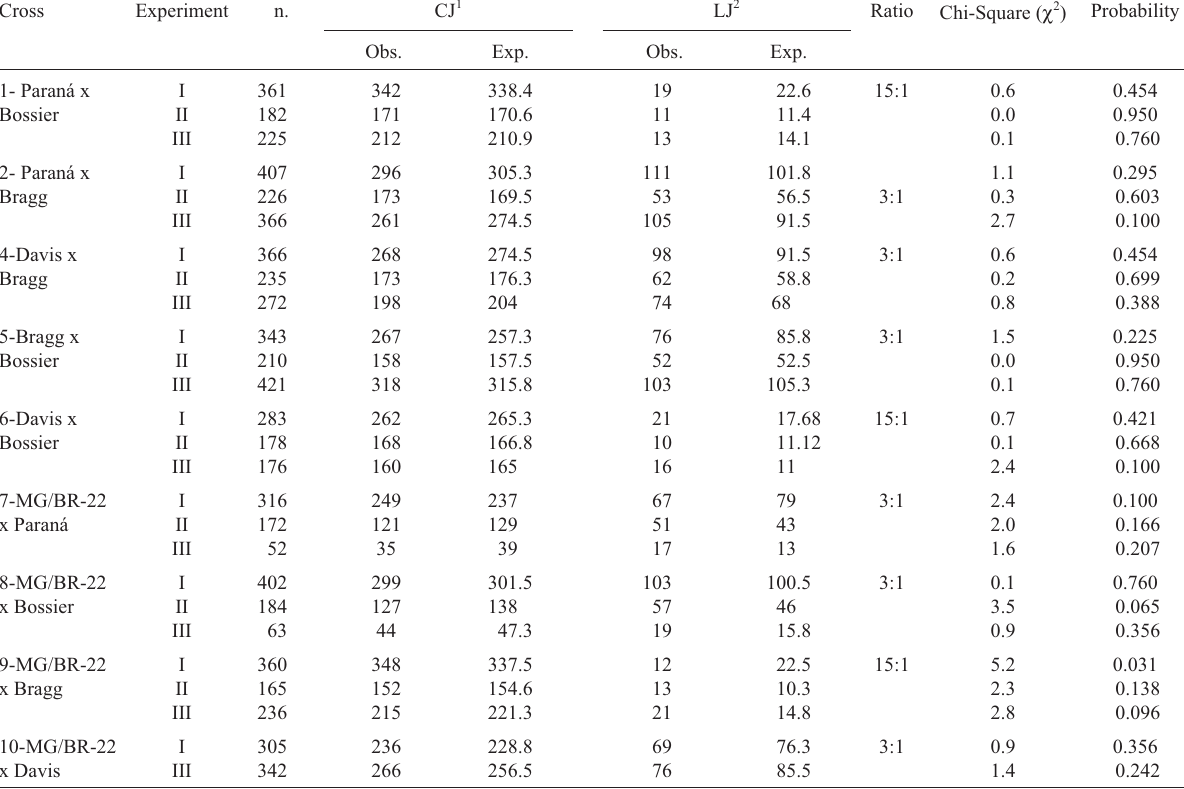
Table III - Observed and expected phenotypic ratios of number of days to flowering in the F 2 populations. Cross Experiment n. CJ 1 LJ 2 Ratio Chi-Square ( χ 2 ) Probability Obs. Exp. Obs. Exp.